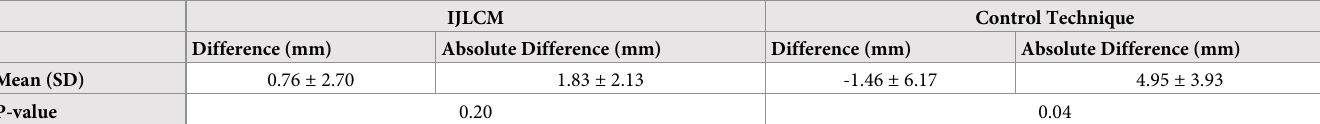
Table 1. Analysis of differences in pre-operative joint line height measurements performed by senior orthopaedic surgeons.